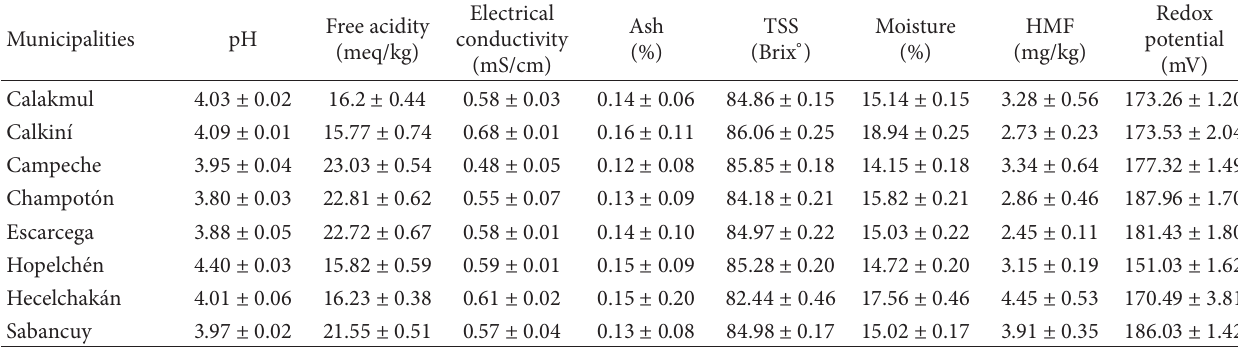
Table 3: Physicochemical for honey samples of Campeche